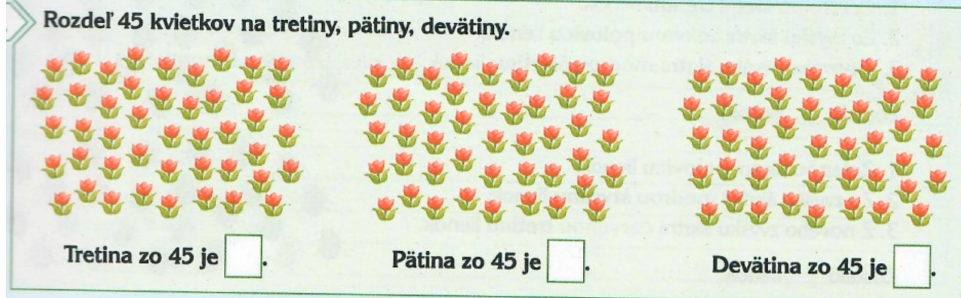
Figure 1. Task: Divide 45 flowers into thirds, fifths, ninths [14].